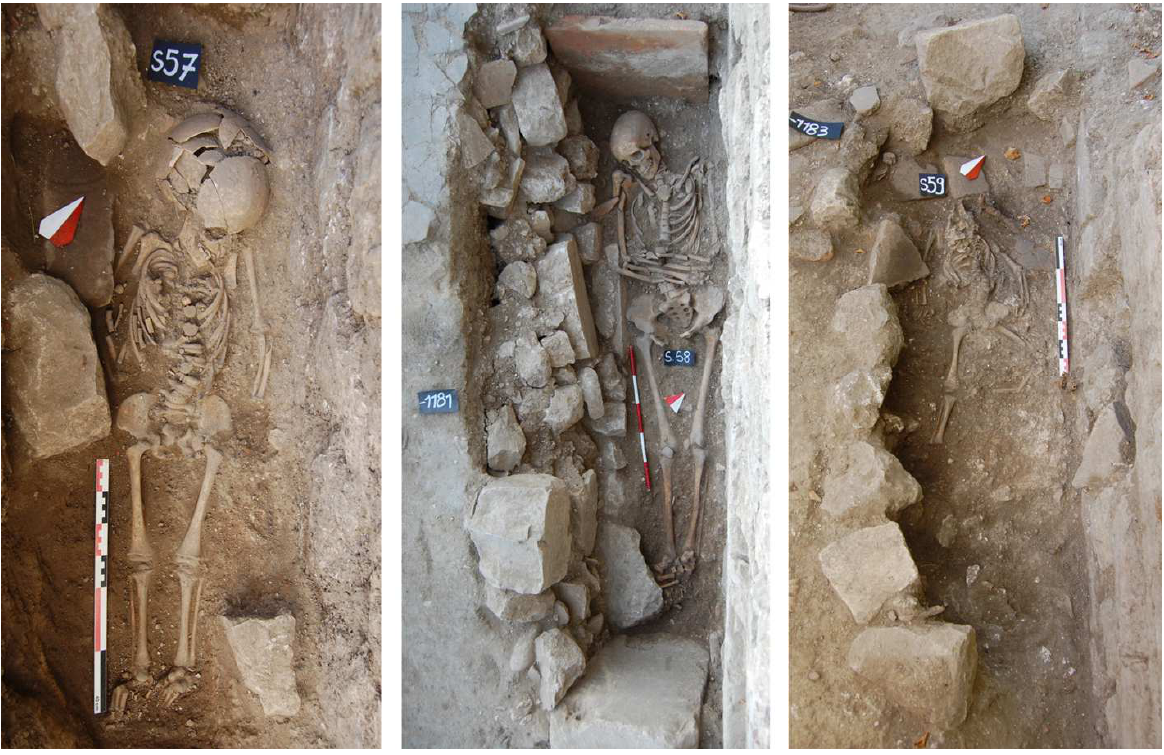
Figure 2. Photos of the burials subject of the